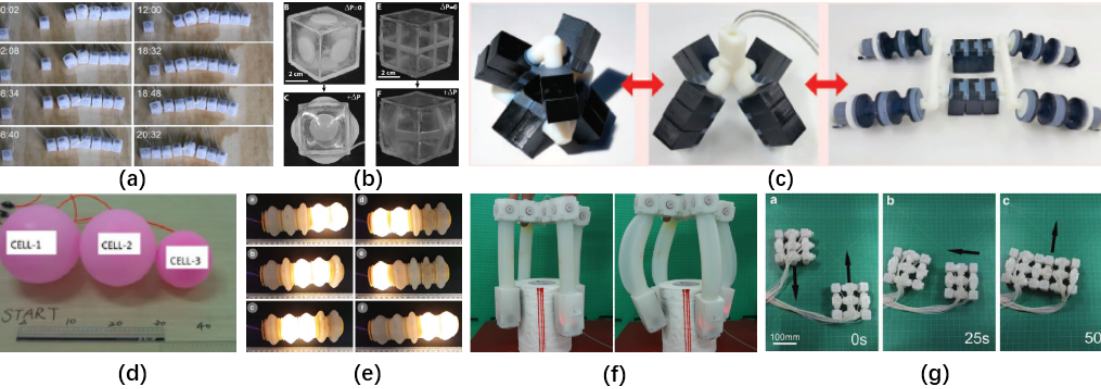
Figure 1. Various soft modular robots in past work. ( a ) Soft modular robots imitating the capacity of cells. ( b ) Soft modular cubes with heterogeneous surfaces. ( c ) Soft modules that can be assembled. ( d ) Multi-spherical modular soft robot. ( e ) Soft modular robots actuated by voice coil. ( f ) The reconfigurable bending modules. ( g ) The reconfigurable omnidirectional soft